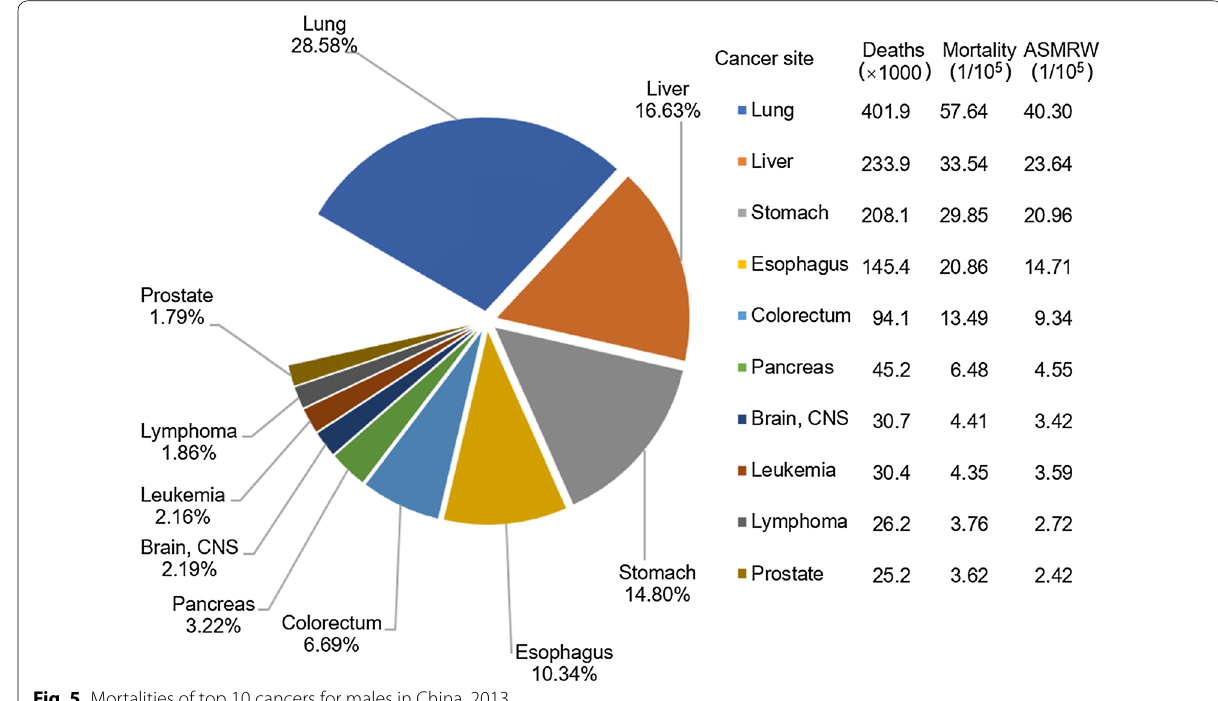
Fig. 5 Mortalities of top 10 cancers for males in China, 2013